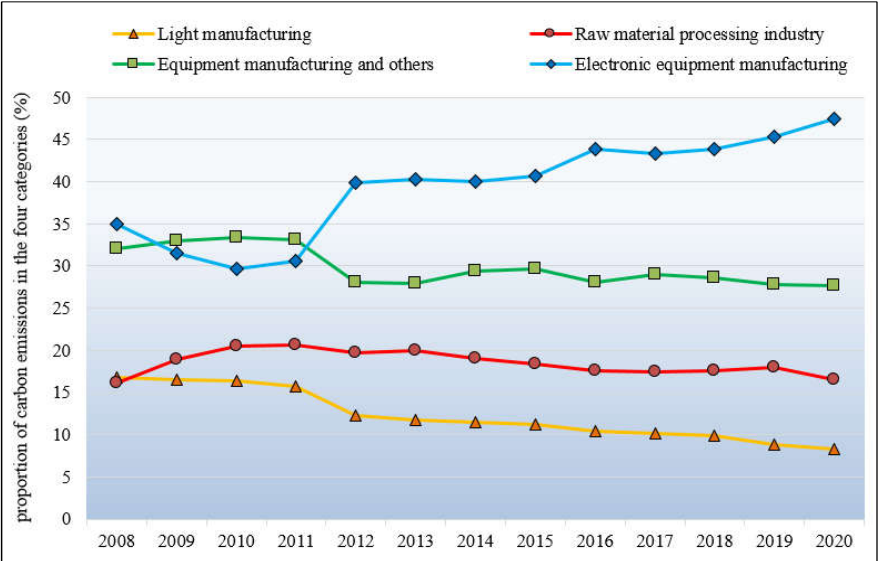
Figure 3. Industry heterogeneity of CO 2 emissions from manufacturing in Shenzhen.